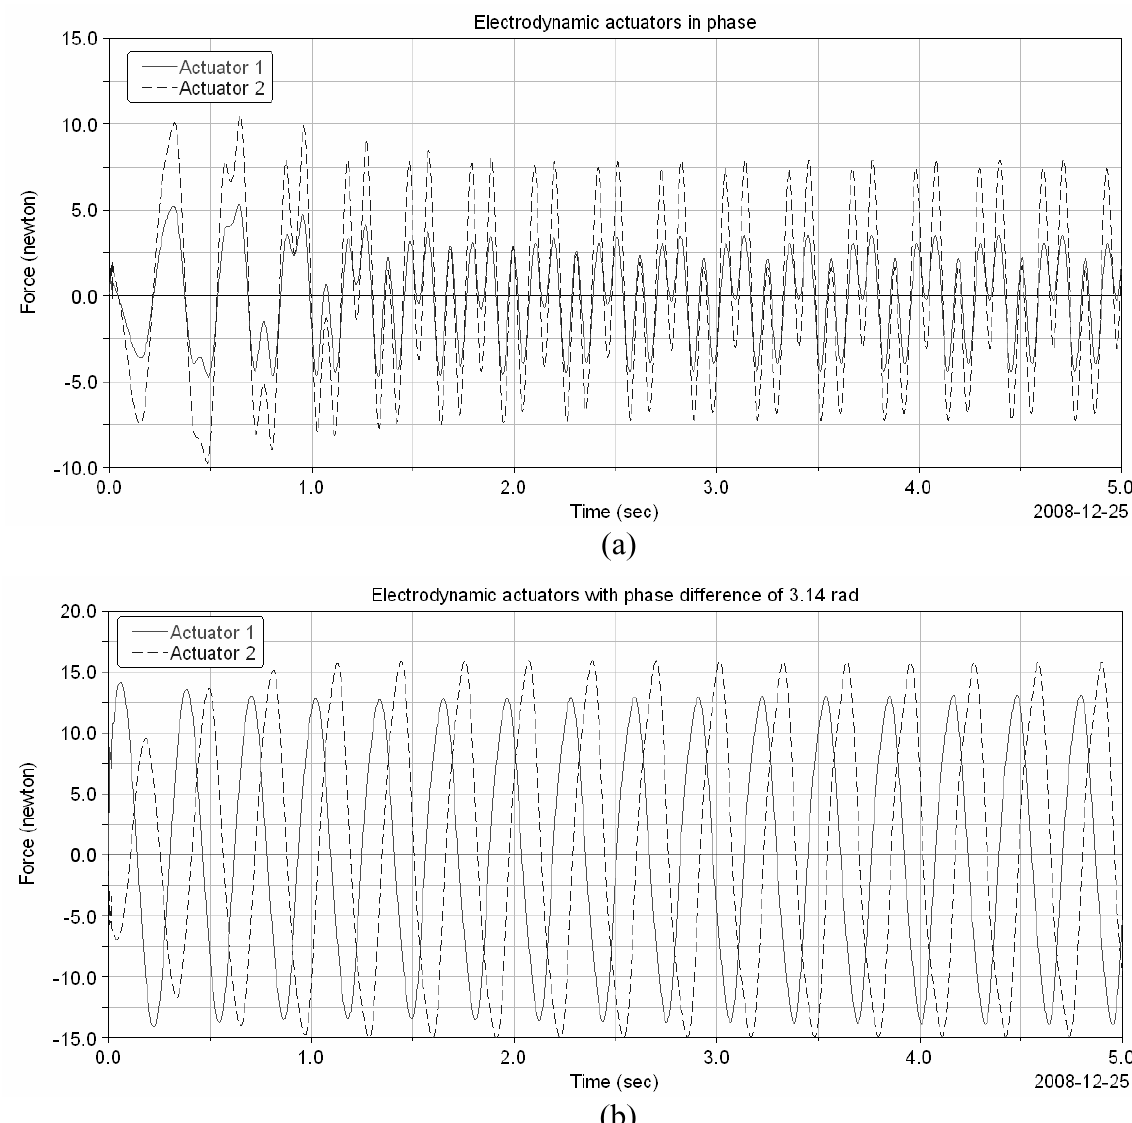
Fig. 9. Electrodynamic actuator